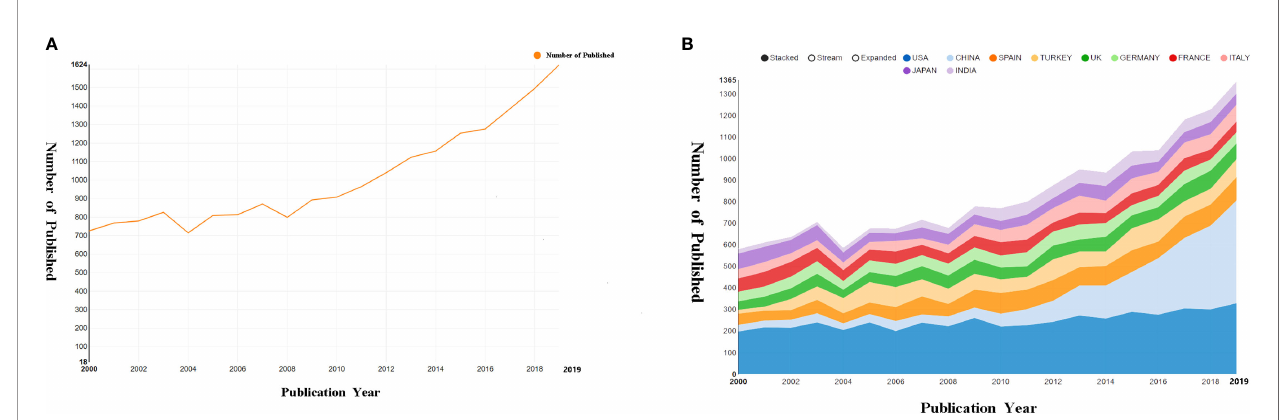
FIGURE 2 | Publication trend. (A) Number of publications per year. (B) Number of publications in the top 10